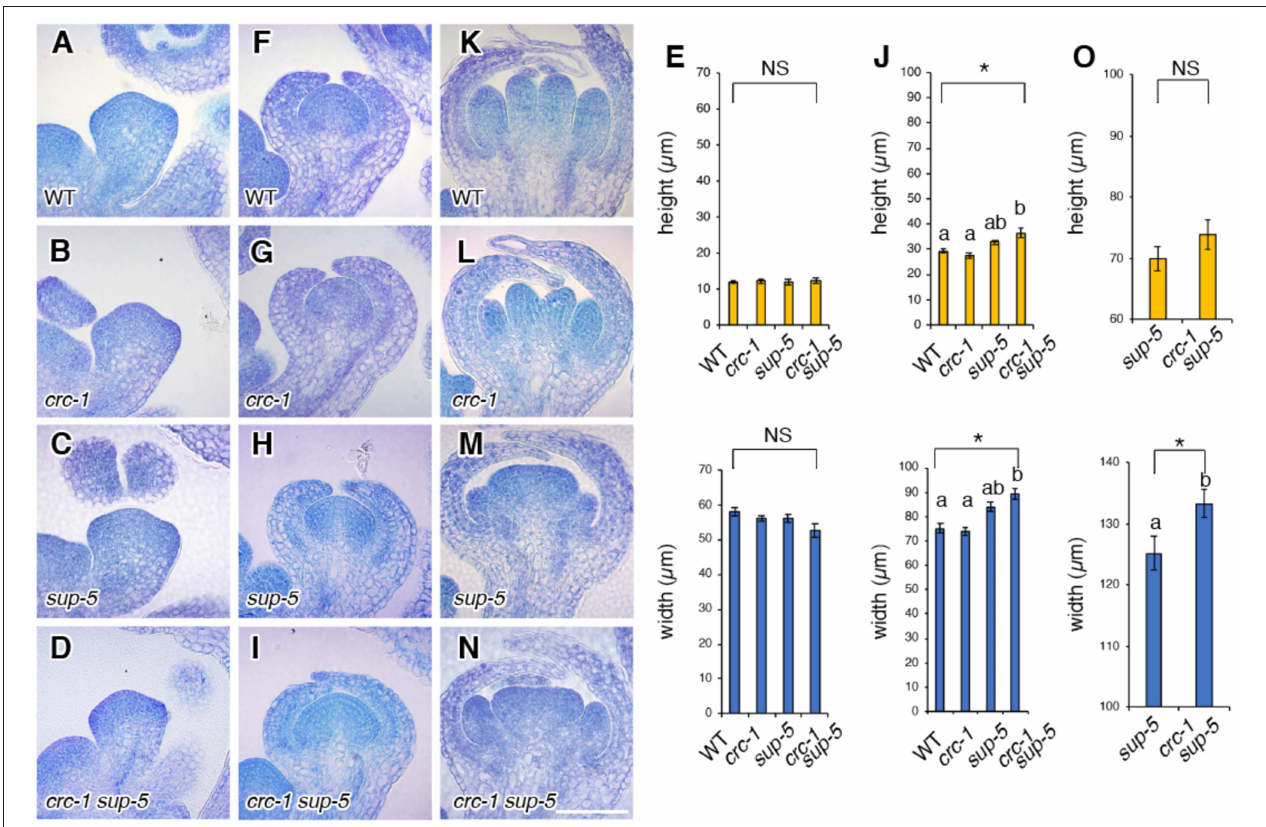
FIGURE 3 | Comparison of floral meristem height and width among the wild type, crc-1 , sup-5 , and sup-5 crc-1 at different floral stages. (A–D) Vertical cross sections of stage 3 floral meristems. (A) The wild type, (B) crc-1 , (C) sup-5 , and (D) crc-1 sup-5 . (E) Quantification of floral meristem height and width at stage 3. (F–J) Vertical cross sections of floral meristems at stage 5. (F) The wild type, (G) crc-1 , (H) sup-5 , and (I) crc-1 sup-5 . (J) Quantification of floral meristem height and width at stage 5. (K–O) Vertical cross sections of floral meristems at stage 6. (K) The wild type, (L) crc-1 , (M) sup-5 , and (N) crc-1 sup-5 . (O) Quantification of floral meristem height and width at stage 6. Mean ± SEM are shown. Scale bars represent 50 µ m. For multiple comparisons, asterisks indicate significant differences based on one-way ANOVA. The same letters indicate non-significant differences, whereas different letters indicate significant differences based on the post-hoc Tukey HSD test ( p < 0.01). For single comparisons, the p -value was determined using the Student’s t -test (* p <